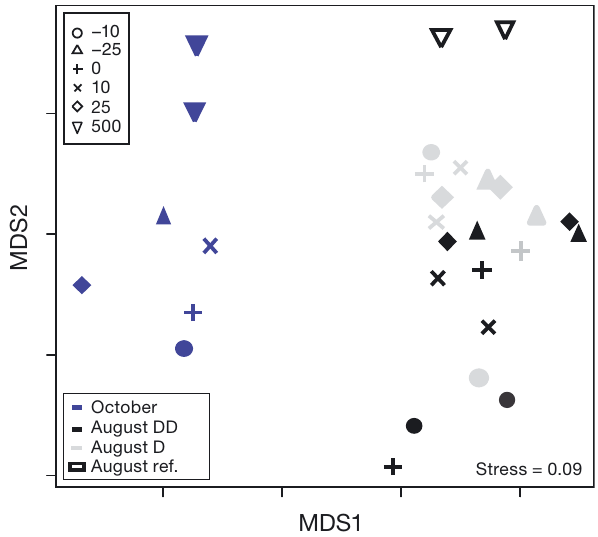
Fig. 6. Non-metric multidimensional scaling plot (data were pooled for each station along each transect) of community structure at 5 distances (−25, −10, 0, 10 and 25 m) along tran- sects leading away from mussel longlines of 2 densities (standard and double density) and reference stations in August and October